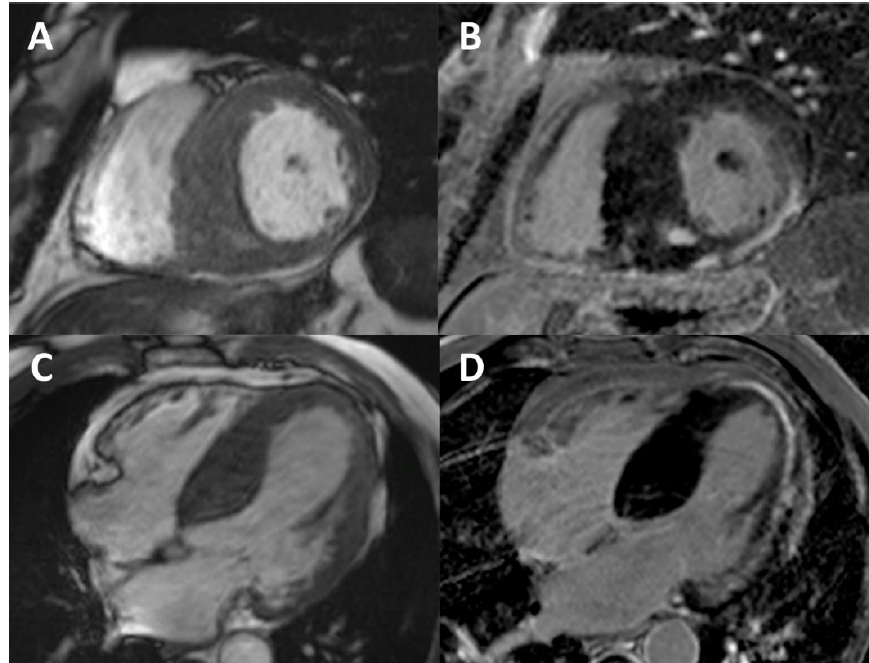
Figure 4. Cardiac MRI (3.0 Tesla) in a Fabry patient with advanced cardiomyopathy. Cine (balanced steady-state free precession sequence) images at the basal LV short-axis slice ( A ) and four-chamber view ( C ) showing massive and asymmetrical LVH (maximal thickness 30. mm at the septum) with thinning of the posterior wall (2 mm). LGE at the basal LV short-axis slice ( B ) and four-chamber view ( D ) showing fibrosis of the inferior and inferolateral walls and apex and focal fibrosis in the septum, where the LVH is more pronounced.